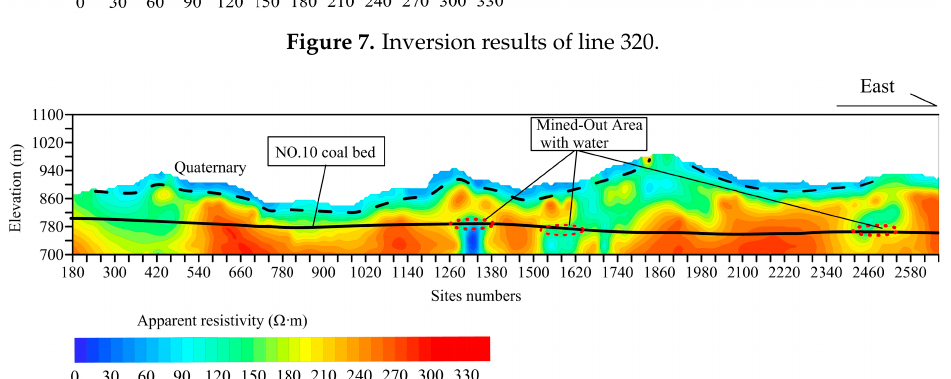
Figure 7. Inversion results of line 320.